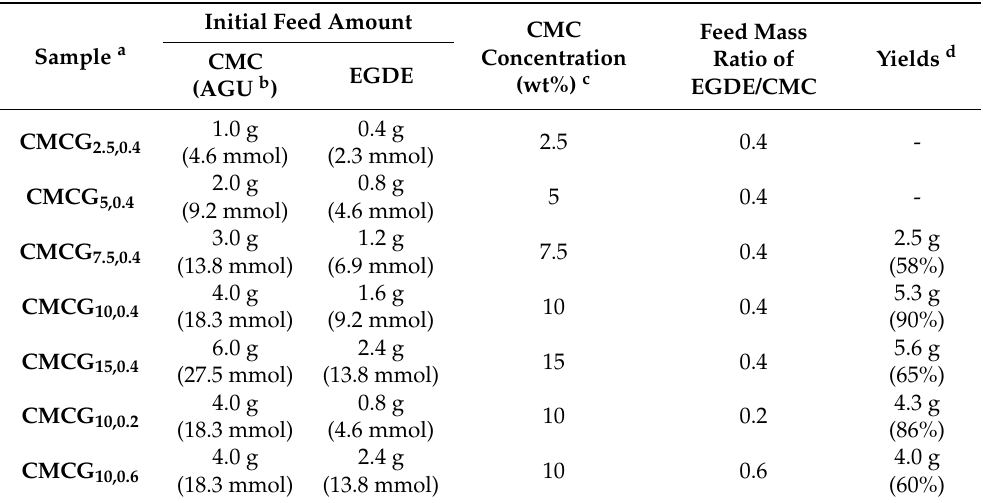
Table 1. Initial feed amount of carboxymethyl cellulose sodium salt (CMC) and ethylene glycol digly- cidyl ether (EGDE) and yields from the preparation of the spherical CMC hydrogel (CMCG)